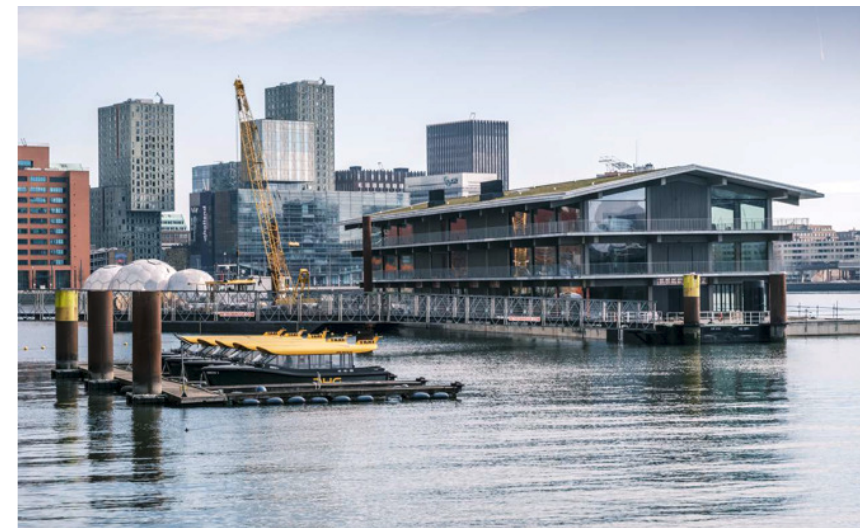
Figure 3. Floating offices in Rotterdam. Source: BMI